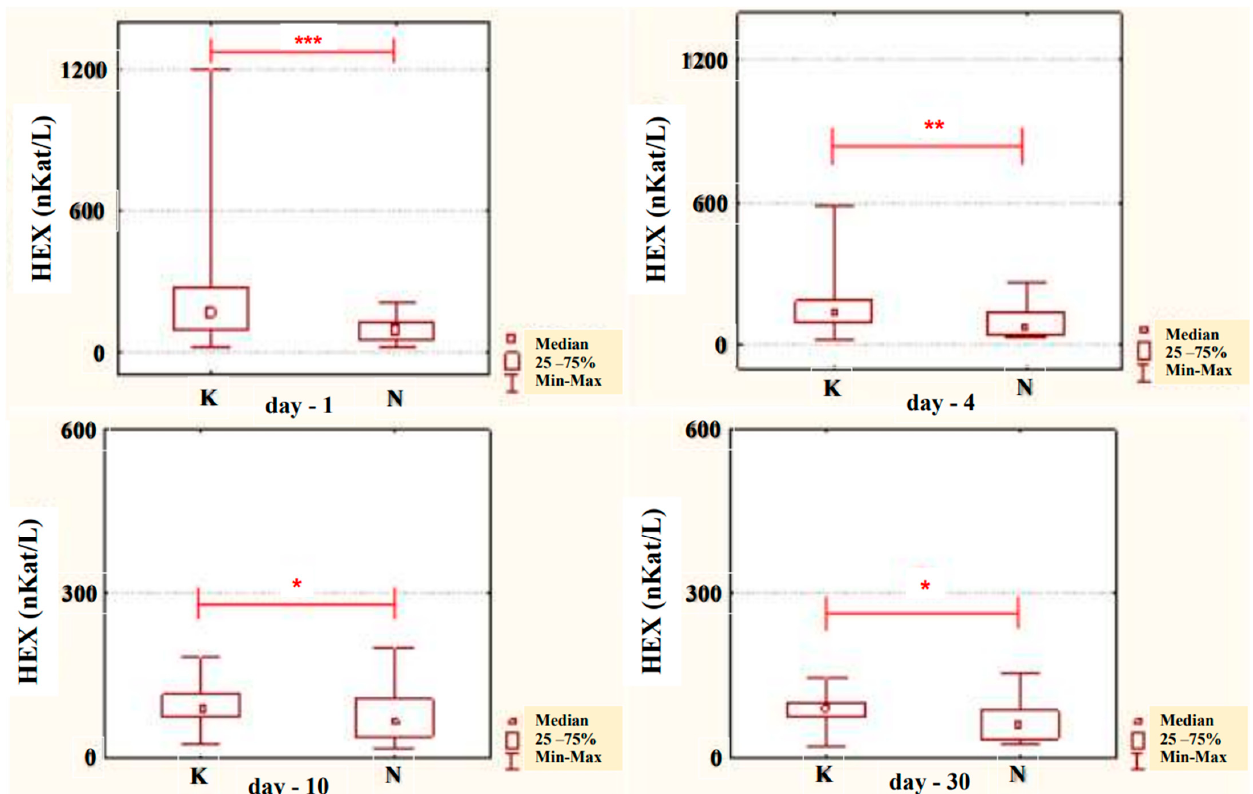
Figure 6. Urinary HEX activity concentration (nKat/L) in patients addicted to alcohol and treated with neoglandin (N) compared to the control group patients (K) who were addicted to alcohol but not treated with neoglandin; * p < 0.05, ** p < 0.01, *** p < 0.001.